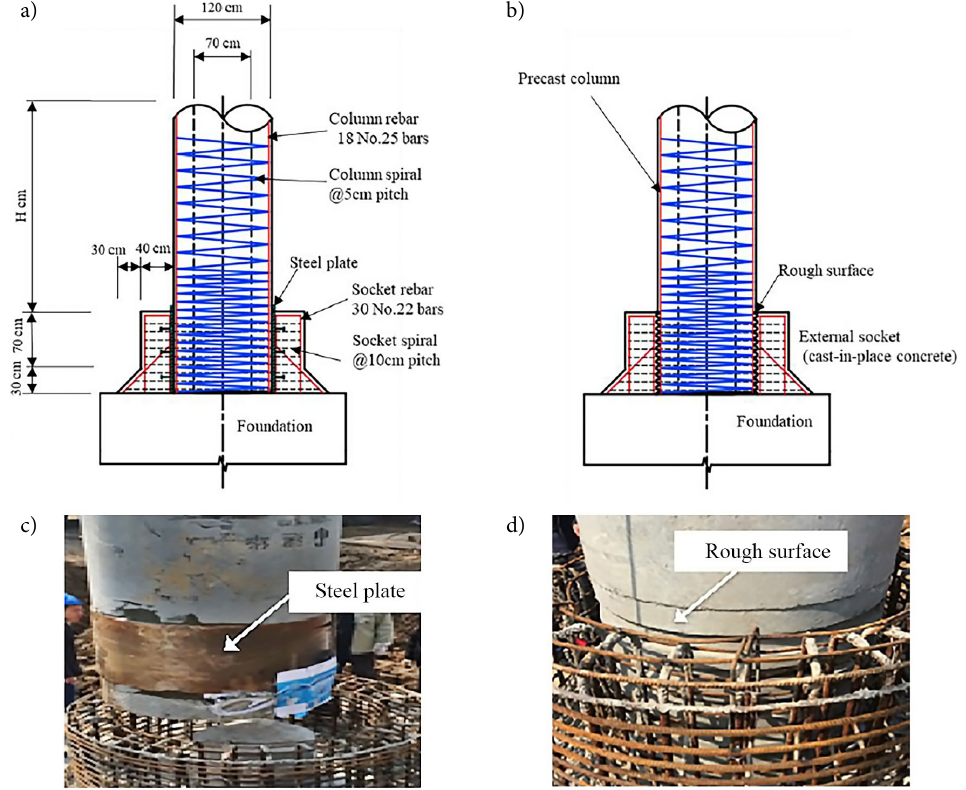
Figure 1. Foundation-column connection: a – Elevation of Type A connection; b – Elevation of Type B connection; c – Photograph of Type A connection; d – Photograph of Type